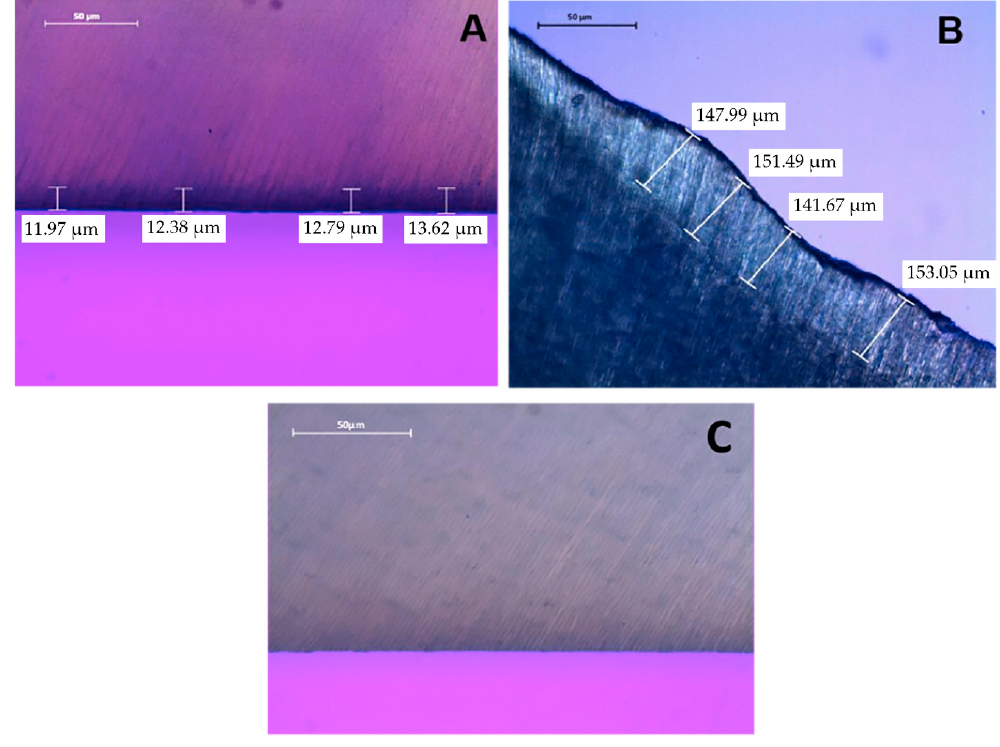
Figure 2. ( A ) Artificial caries lesions provided by Chemical Model; ( B ) Artificial caries lesions provided by Biological Model after removing the softened tissue; ( C ) Sound Dentin.